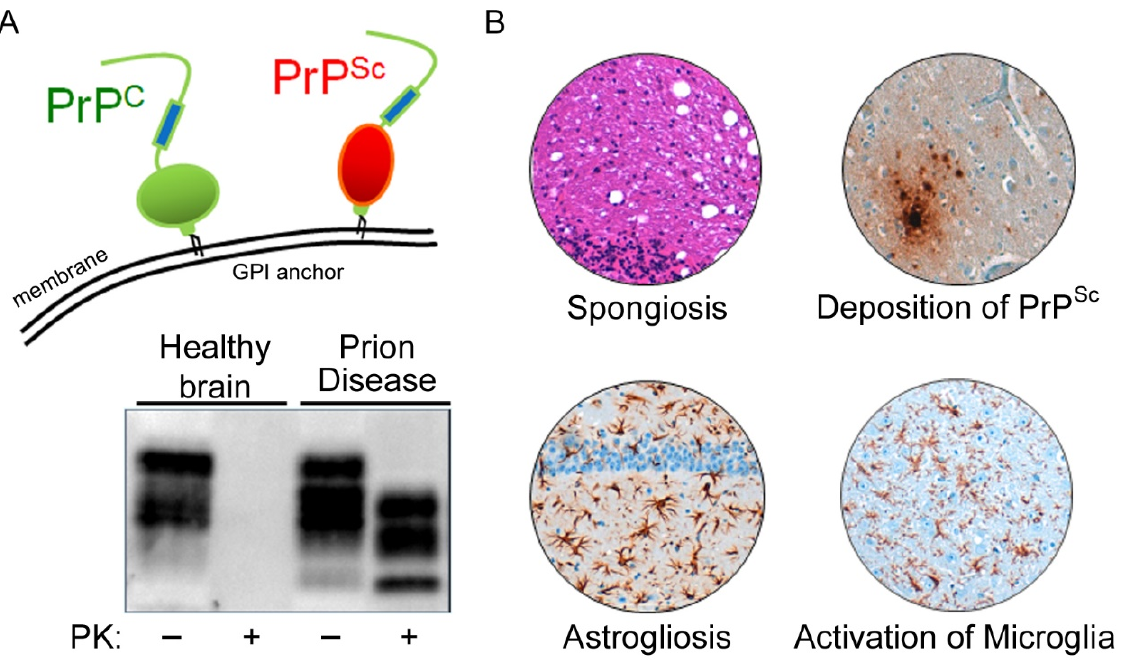
Figure 1. The cellular prion protein is misfolded in prion diseases. ( A ) A glycosylphosphatidylinositol (GPI) anchor tethers the cellular prion protein (PrP C ; schematic in green) to the outer leaflet of the plasma membrane. In prion disease, PrP C is conformationally converted into its disease-associated isoform PrP Sc (schematic in red). Misfolded PrP Sc is more stable against proteolytic digestion and can be detected in prion disease but not in healthy brain tissue after proteinase K (PK) digestion by Western blotting. ( B ) Prion disease histopathological hallmarks include spongiform changes (hematoxylin and eosin (H&E) staining, see vacuolation), deposition of aggregated protein (misfolded PrP Sc ), astrogliosis (GFAP), and microglial activation (IBA1).